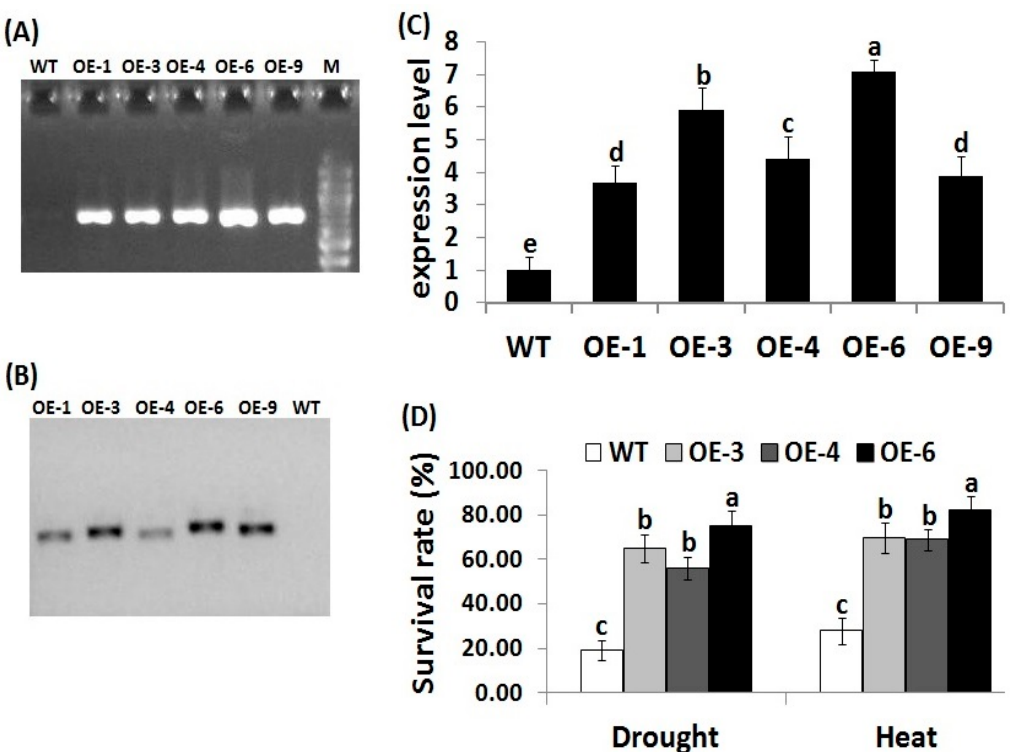
Figure 1. Molecular analysis of the transgenic rice lines. ( A ) PCR amplification of 750 bp of hpt hygromycin resistant gene in the wild-type (WT) and the 5 transgenic (OE) lines. ( B ) Southern blot analysis of the digested genomic DNA from the WT and the 5 transgenic lines. ( C ) Relative expression of OsRab7 in transgenic lines using qRT-PCR analysis. ( D ) Survival rate of the WT and transgenic lines following 10-day recovery after drought and heat treatments. M, 100 bp DNA ladder. Different letters above the columns indicate significant differences between lines ( p ≤ 0.05).